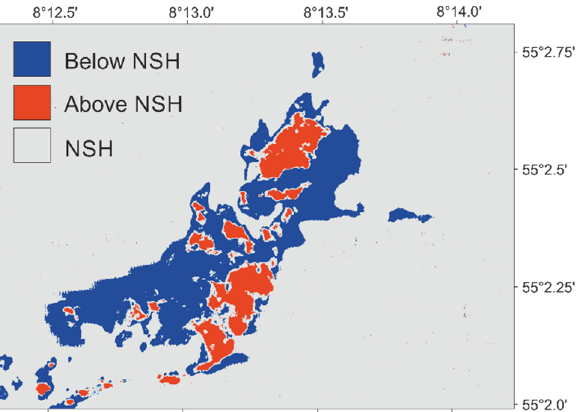
Figure 7. Areas within the rocky reef that are bathymetrically above or below the ‘normal sediment height’ (NSH).